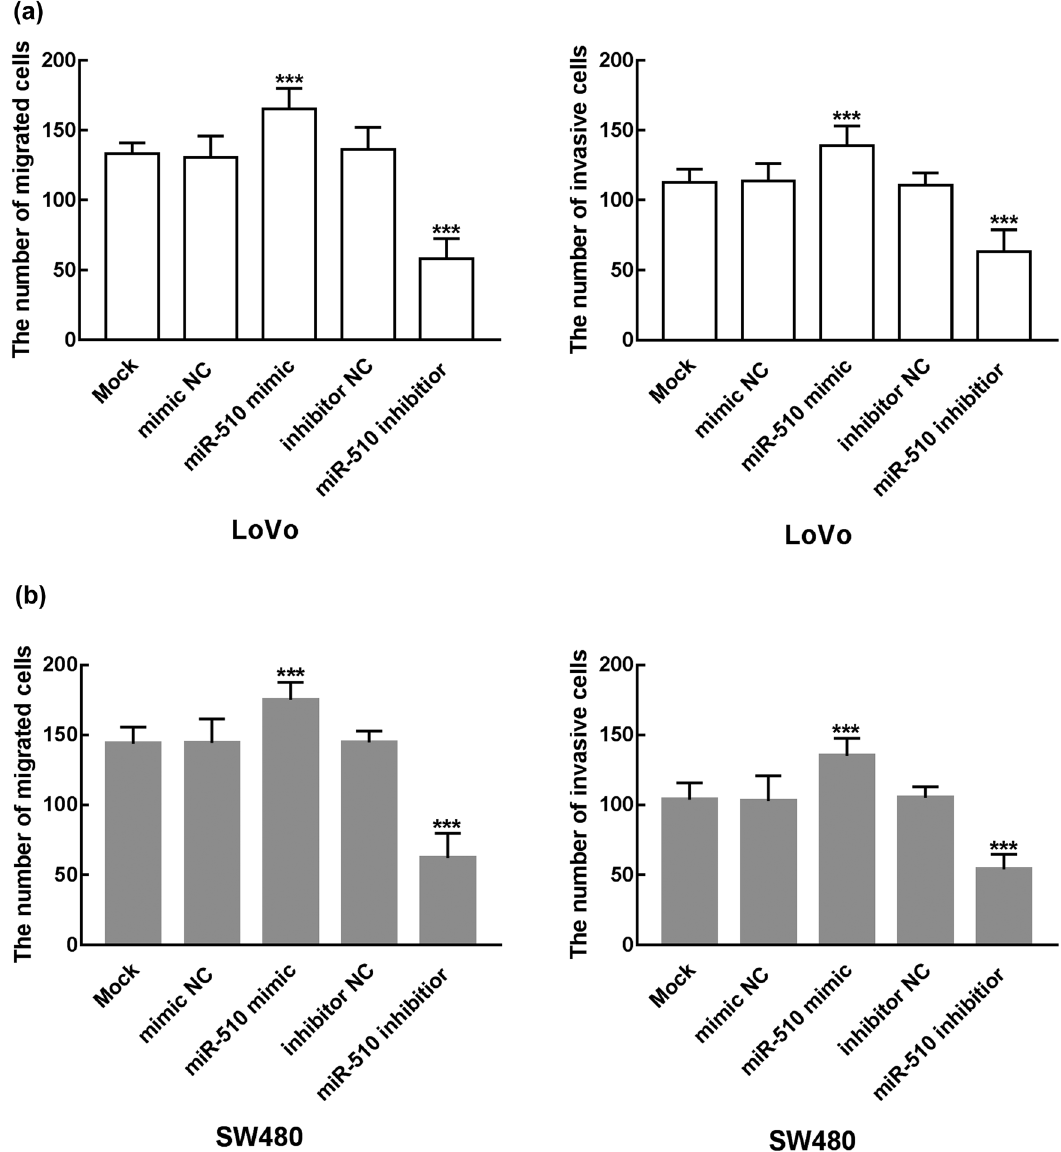
Figure 4: E ff ect of miR - 510 expression level on cell migration and invasion of LoVo and SW480 cells. ( a ) The overexpression of miR - 510 signi fi cantly enhanced cell migration and invasion of LoVo cells, while the knockdown of miR - 510 signi fi cantly inhibited cell migration and invasion of LoVo cells ( *** P < 0.001 ) . ( b ) The overexpression of miR - 510 signi fi cantly enhanced cell migration and invasion of SW480 cells, while the knockdown of miR - 510 signi fi cantly inhibited cell migration and invasion of SW480 cells ( *** P < 0.001 )